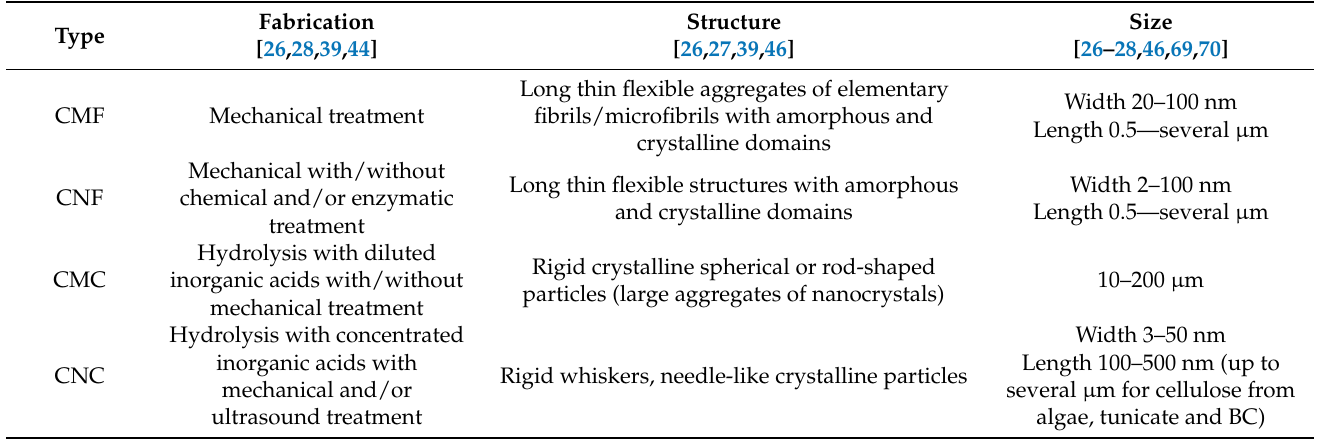
Table 1. Cellulose micro- and